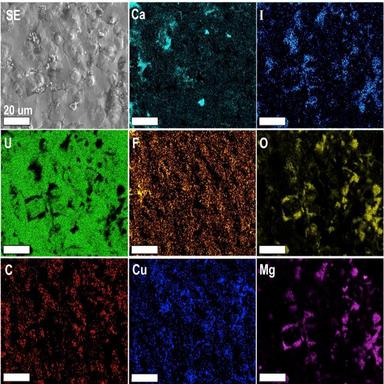
Large area image and elemental X-ray maps of the metal surface.